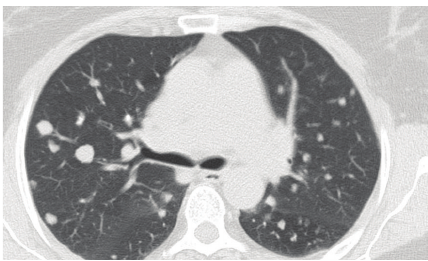
Figure 1: Bilateral multiple nodules with regular margins are detected in the CT of the patient.